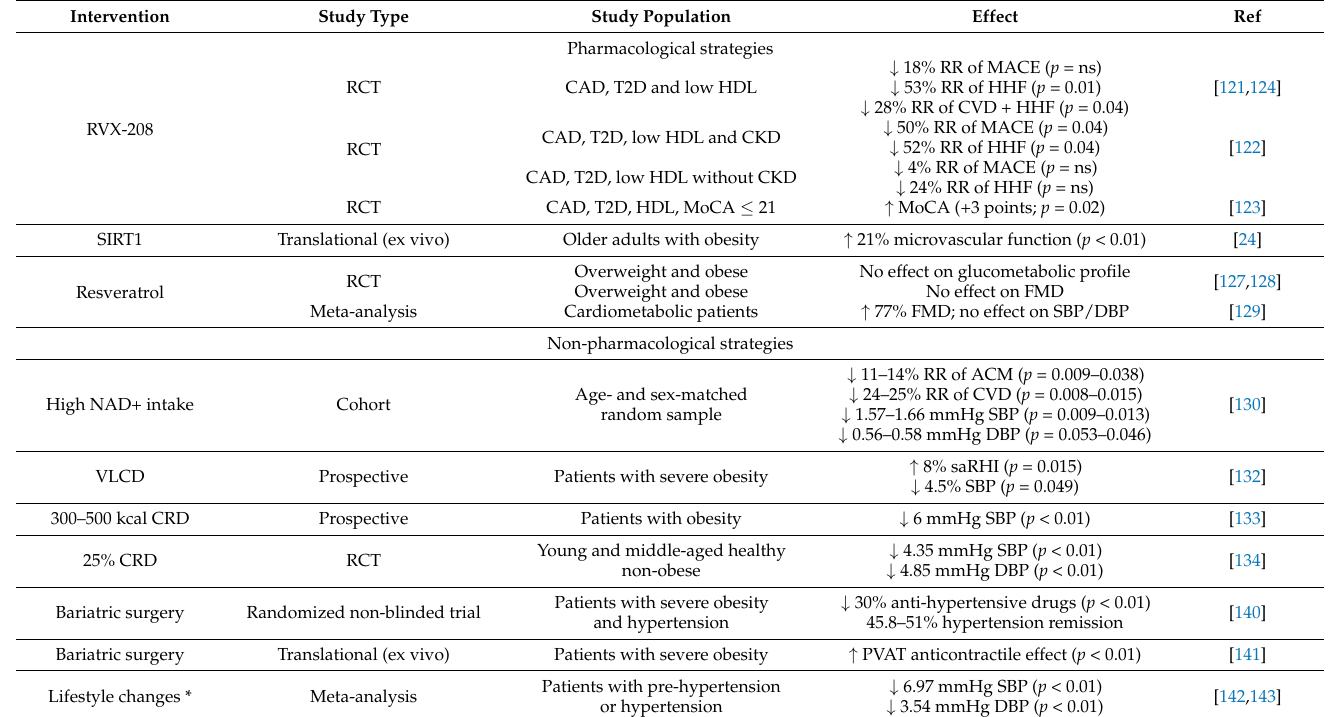
Table 1. Human evidence (direct or indirect) of targeting the epigenetic signature of arterial